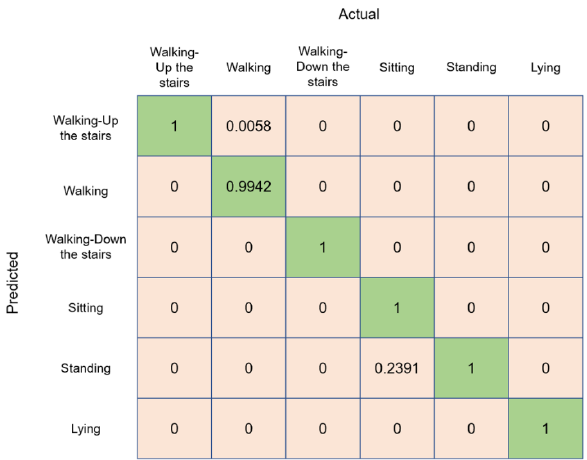
Figure 7. Normalized confusion matrix of Random Forest (RF).